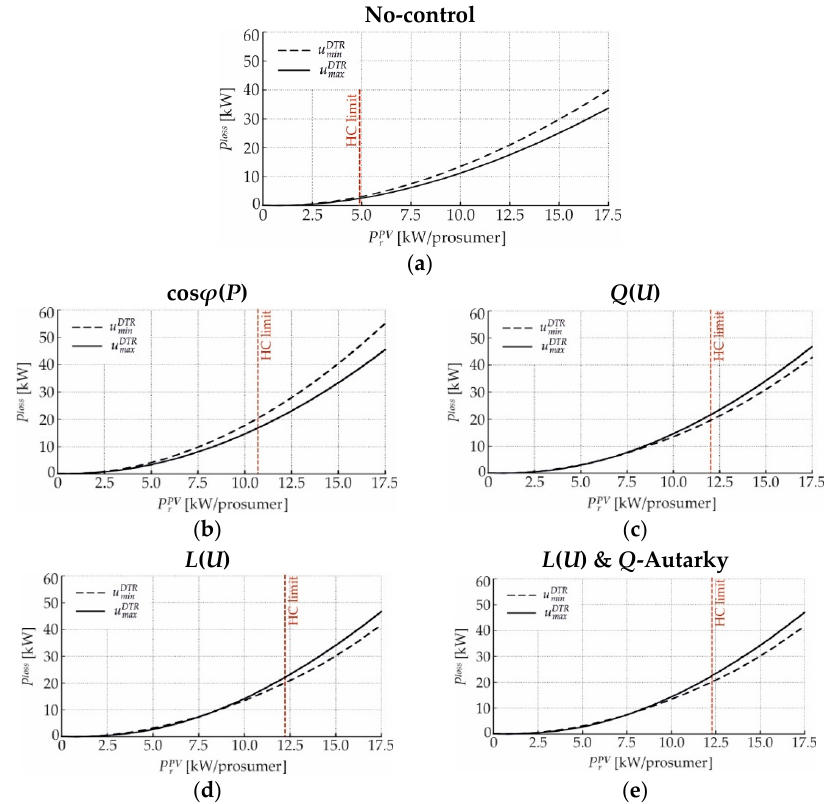
Figure 10. Grid losses of the short overhead line test-feeder for the minimal and maximal DTR